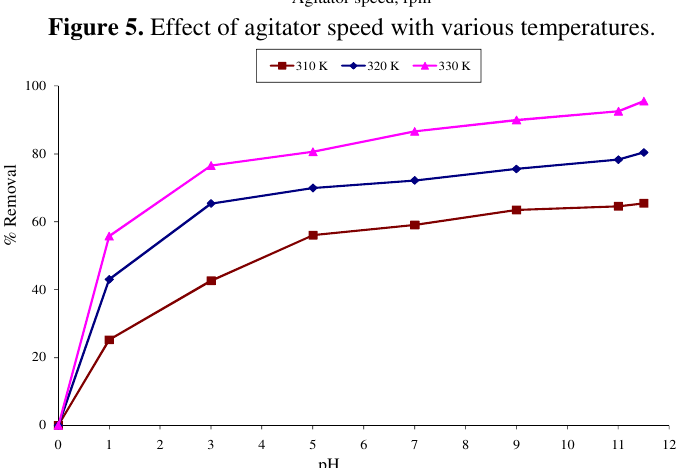
Figure 6. Effect of pH with different